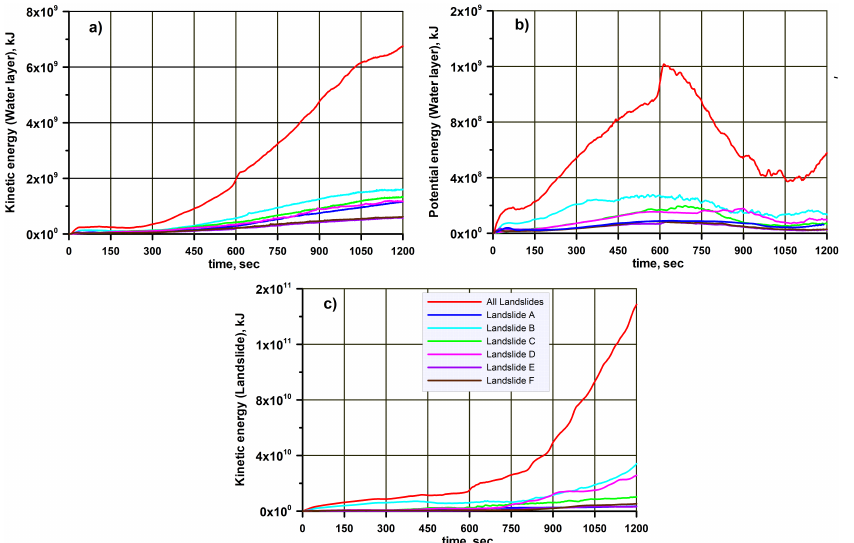
Figure 7. Kinetic and Potential energy. ( a ) Kinetic energy of the water layer; ( b ) potential energy of the water layer; ( c ) kinetic energy of the